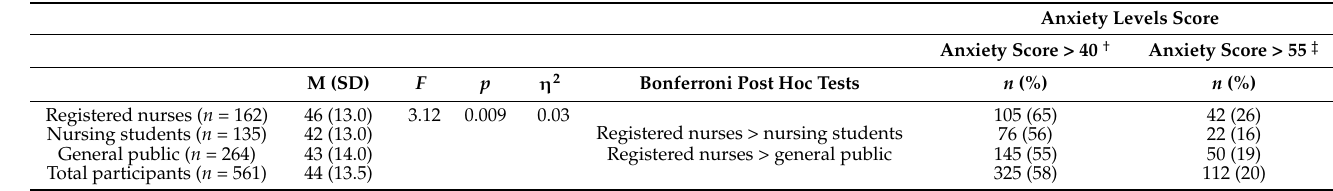
Table 2. Proportion of registered nurses with clinically significant and severe anxiety levels; results of ANCOVA and Bonferroni post hoc tests on anxiety levels ( n =